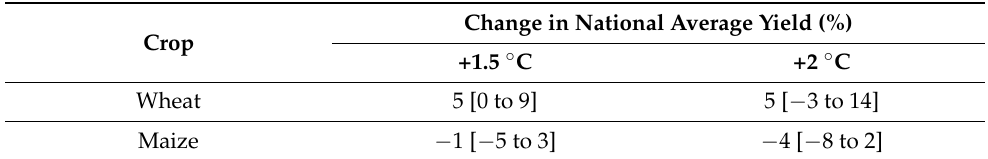
Table 4. The change in national yield of wheat and maize under 1.5 ◦ C and 2.0 ◦ C levels of tempera- ture change. Change in National Average Yield (%) Crop +1.5 ◦ C +2 ◦ C Wheat 5 [0 to 9] 5 [ − 3 to 14] Maize − 1 [ − 5 to 3] − 4 [ − 8 to